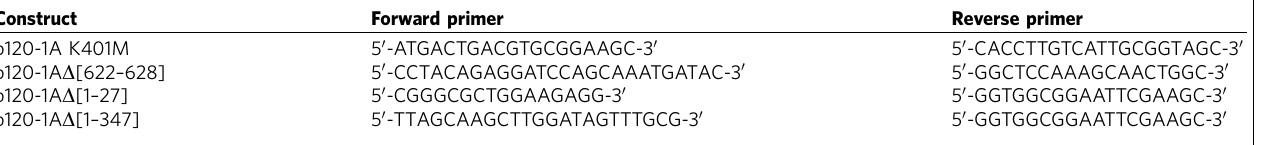
Table 1 | primers used to clone p120-1A constructs.